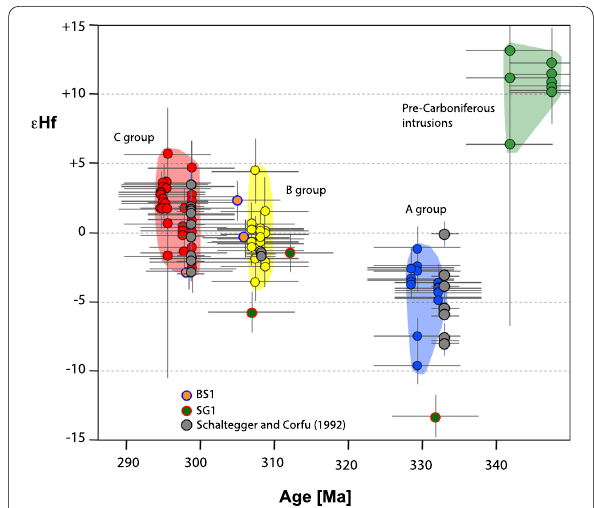
Fig. 7 Initial Hf isotope composition of zircon from the four intrusive pulses of the Aar batholith, determined by LA-MC-ICP-MS. Color coding is identical to Fig. 6a; εHf uncertainties are taken from Table F5, age uncertainties represent “extended error”, see the Methods section for more information. Data taken from Schaltegger & Corfu (1992) are in grey; an estimated age error of 2 Ma has been ±